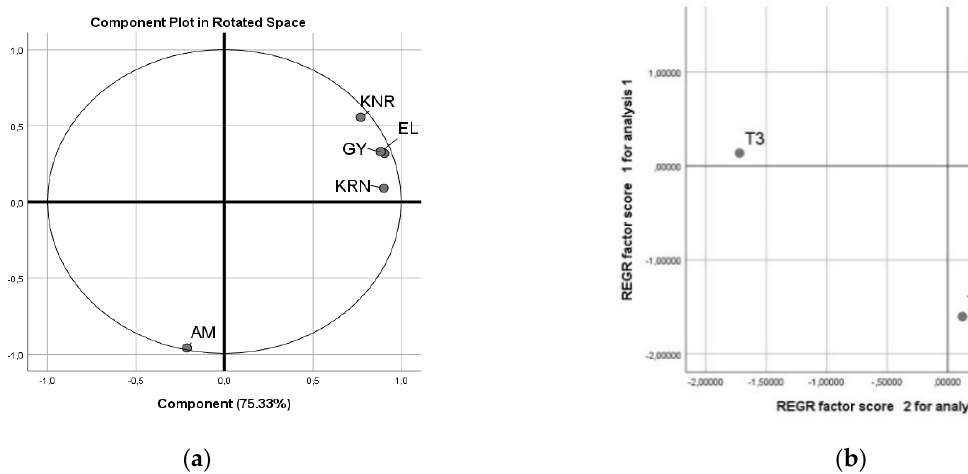
Figure 4. ( a ) Plot of principal component analysis of the variables in the study concerning the effects of the detasseling and kernel properties (KRN, KNR, El, KW) and grain yield (GY). KRN-kernel row number, KNR—kernel number per row, EL—ear length, KW—1000-kernel weight; ( b ) regression factor score of principal comment analysis of the detasseling and kernel properties (KRN, KNR, El, KW).